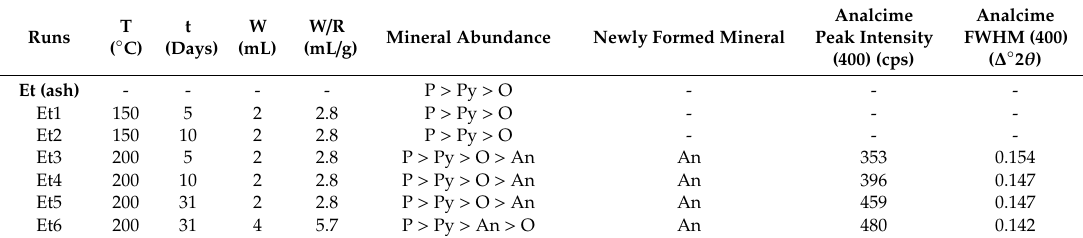
Table 2. Experimental setup and list of the products obtained for each run in order of decreasing abundance, as detected by XRPD, TEM / EDS, and SEM / EDS. Full width at half-maximum (FWHM). P = plagioclase; Py = pyroxene; O = olivine; A = analcime. Et6 ash was altered with the addition of water from 2 mL to 4 mL. Water with initial pH = 5; water-to-rock ratio (W /